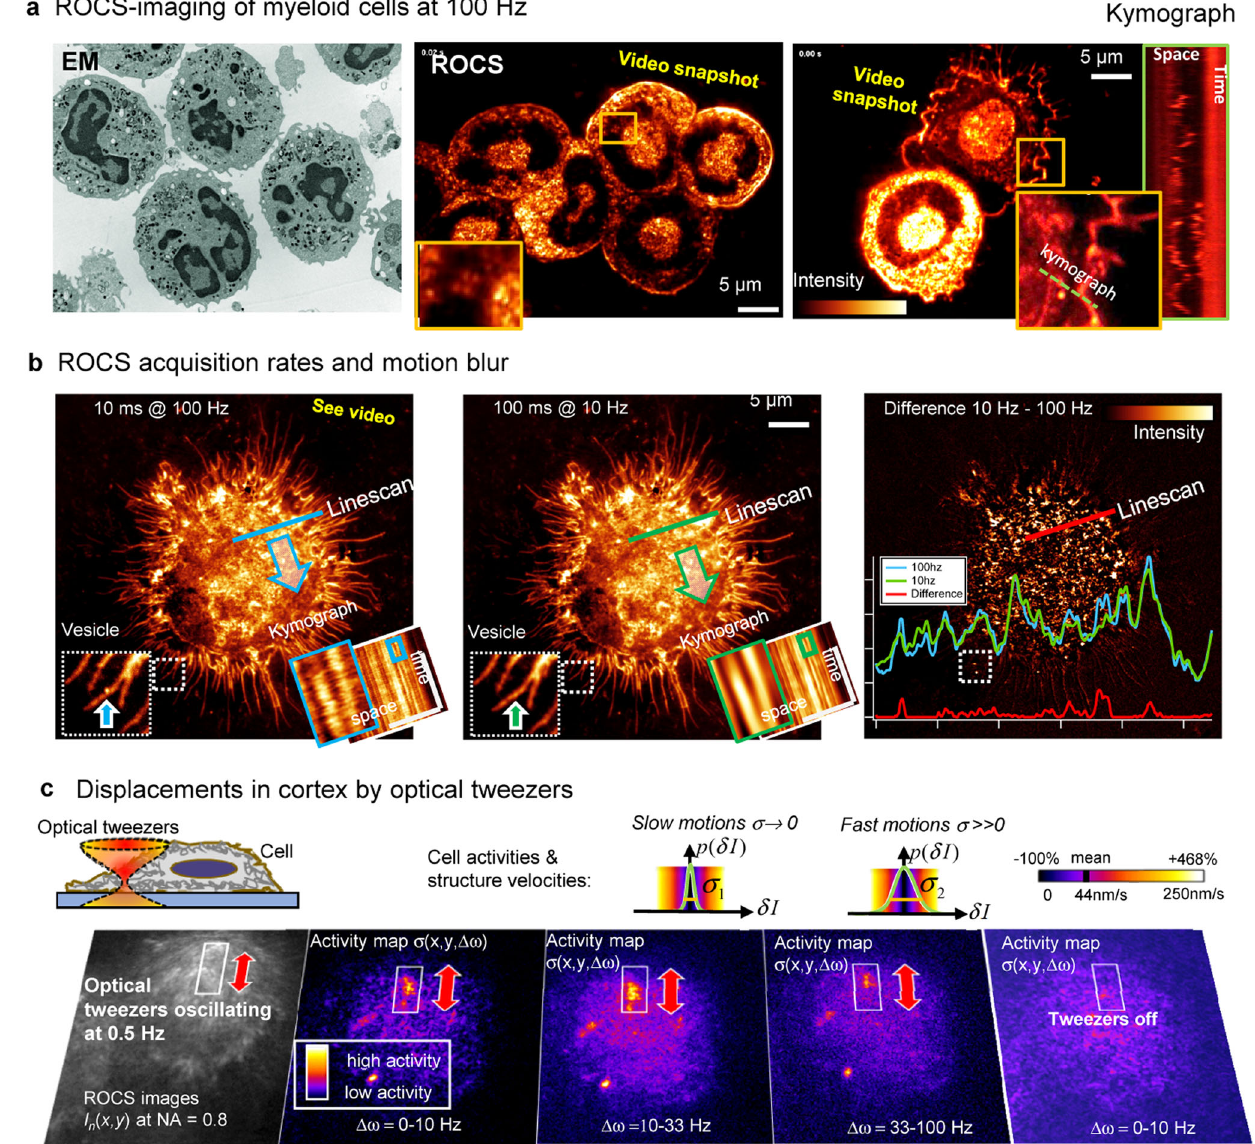
Fig. 2 Dynamic imaging and activity maps. a Electron micrograph of fi xed myeloid cells (iStock.com/Dlumen) versus ROCS image of living myeloid cells recorded at 100Hz. The kymograph shows cell structures moving at 100 Hz. i J774 macrophages image d with ROCS at 100Hz (and down-sampled to 10Hz). T he ROI reveals a fast vesicle at 100 Hz, which is invisible at 10Hz due to motion blur. Intensity kymographs from line scan s inside the cell body reveal much higher dynamics at 100 Hz. Right: Snapshot of intensity difference between images at 10Hz and 100 Hz with line scans in corresponding colors. c Oscillating optical tweezers (100mW at 1064nm) induce activity in the cell cortex of J774 macrophages. Non-TIR dark fi eld ROCS-image sequence I n ( x,y ) recorded at NA = 0.8 hardly reveal any cellular responses left to the red arrow. Activity maps σ ( x, y , Δ ω ) reveal cortex activity at 3 different timescales ( Δω − 1 = 0.1 – 1s, 0.03 – 0.1s, 10 – 30ms) within ROI (white box). Slow motions correspond to small σ (black) and fast motions to a large σ (yellow). Switching the optical tweezers off stops cortex activity immediately. Source data are provided as a Source Data fi